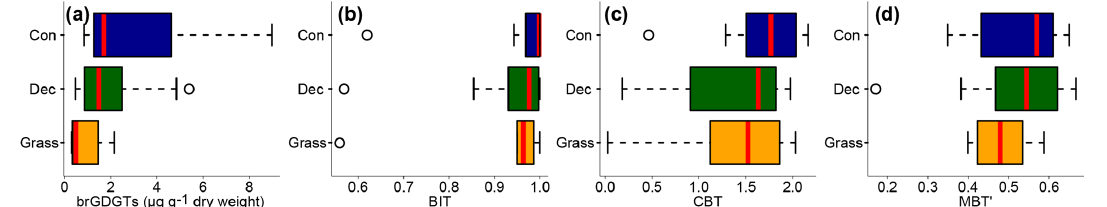
Figure 3. (a) Total concentrations of brGDGTs in microgrammes per gramme of dry weight, as well as (b) BIT, (c) CBT and (d) MBT (cid:48) . Abbreviations: con: coniferous forest sites ( n = 9); dec: deciduous forest sites ( n = 14); grass: grassland sites ( n = 6). Box plots show the median (red line), interquartile range (IQR) with the upper (75%) and lower (25%) quartiles, lowest whisker still within 1.5 IQR of the lower quartile, and highest whisker still within 1.5 IQR of the upper quartile; dots mark outliers.